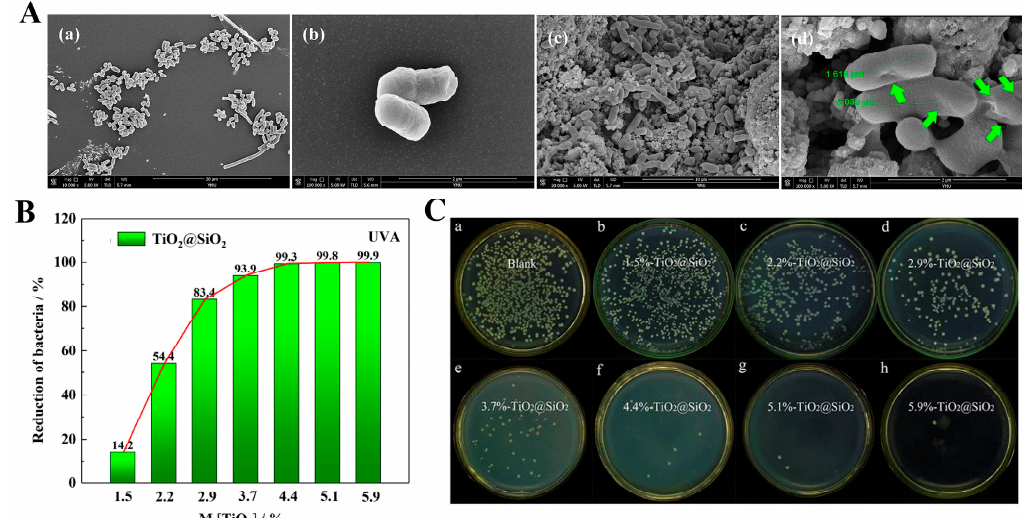
Figure 4. ( A ) SEM images of E. coli before ( a , b ) and after ( c , d ) TiO 2 @SiO 2 treatment; ( B ) image of the antibacterial effect of TiO 2 @SiO 2 hybrid materials with different TiO 2 contents on E. coli under UVA irradiation; ( C ) effect of the antimicrobial property of TiO 2 @SiO 2 hybrid materials under UVA irradiation [50]. Table 1. Antimicrobial effects of different TiO 2 materials under UV